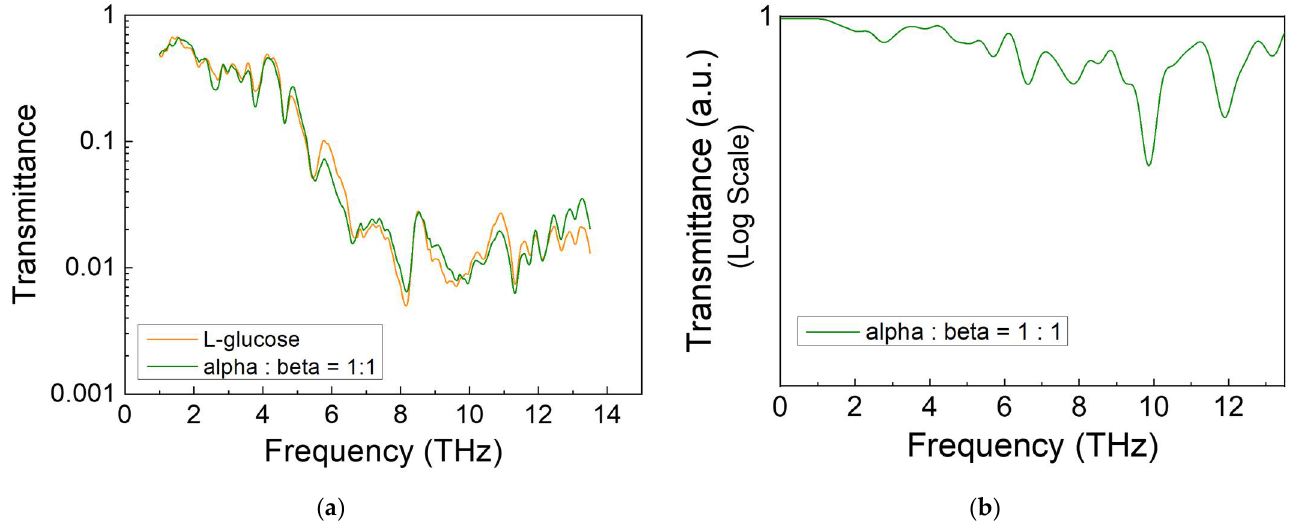
Figure 5. ( a ) Plots of the experimentally obtained THz transmission characteristics of an L-glucose sample and a mixed sample of α- and β-D-glucose (1:1), obtained using our frequency-domain THz spectroscopic system. ( b ) Plot of a DFT simulation showing the THz transmittance characteristics of a mixed sample of α- and β-D-glucose with a mixing ratio of 1:1 over a frequency range of 1–13 THz.